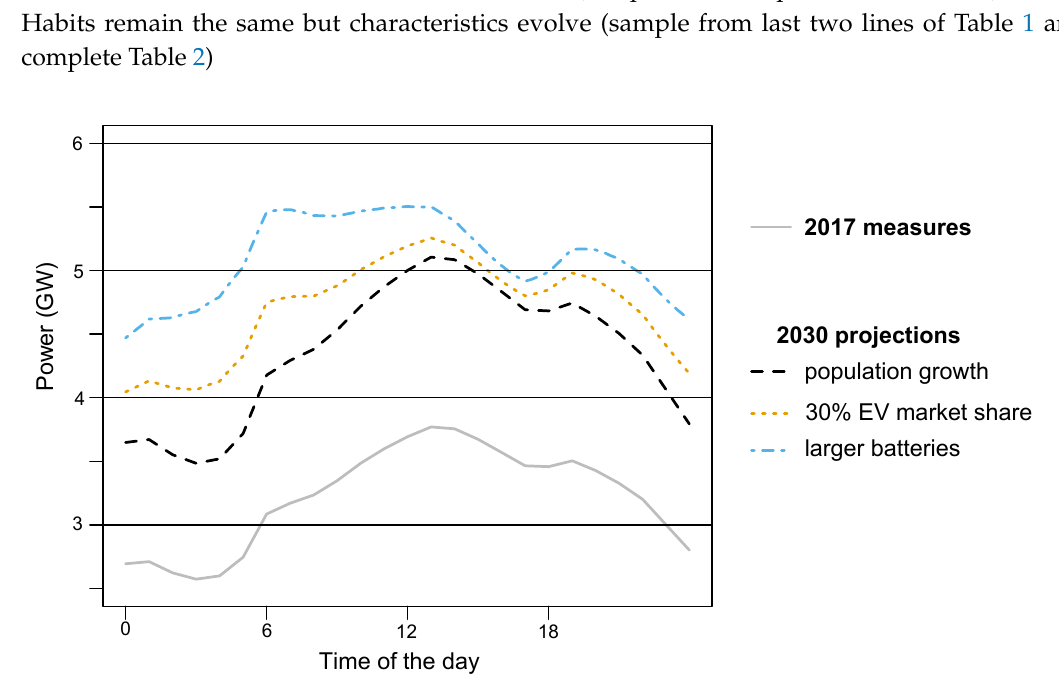
Figure 7. Load curves in South Central zone of Texas in a typical Tuesday in March. The grey solid line represents the load measured in 2017; the black dashed line represents the expected load in 2030 with the same EV market share (1.9%); the orange dotted line represents the expected load with a 30% EV market share and same EV characteristics as of time of writing; the blue mixed line represents this expected load with larger batteries in